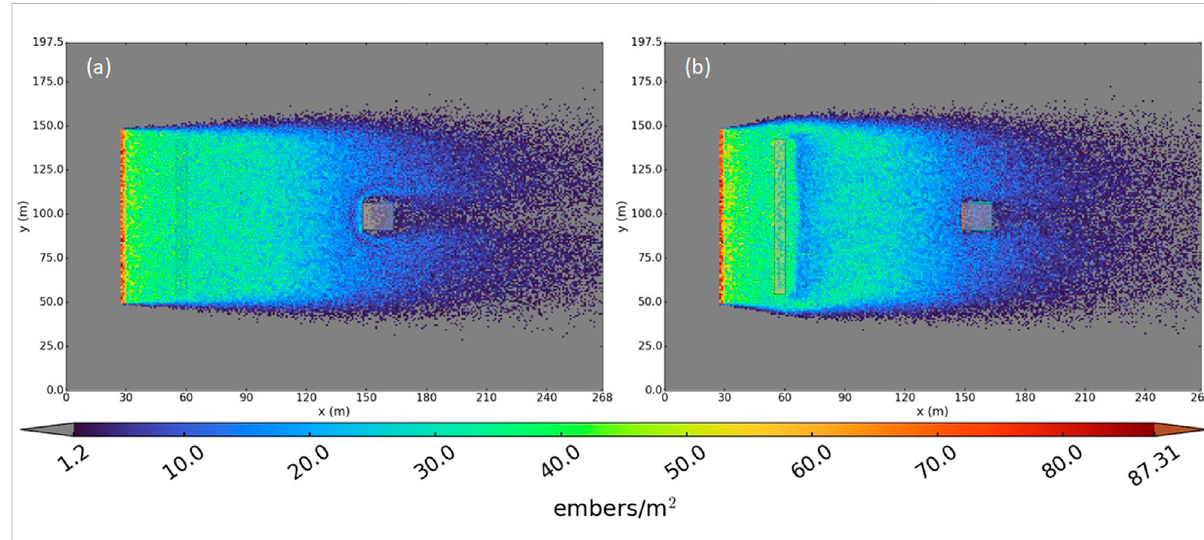
FIGURE 14 Firebrand deposition for the 5H injection location case. (A) Without the fence. (B) With the